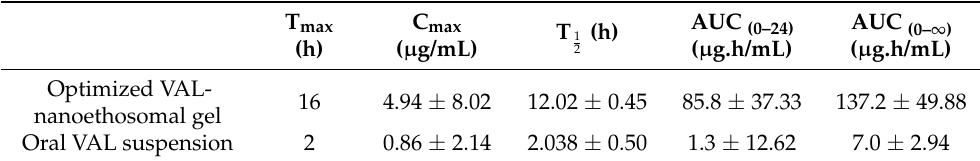
Table 7. Pharmacokinetics parameters of VAL-loaded nanoethosomal gel and oral VAL suspension (mean ± SD, n = 4).